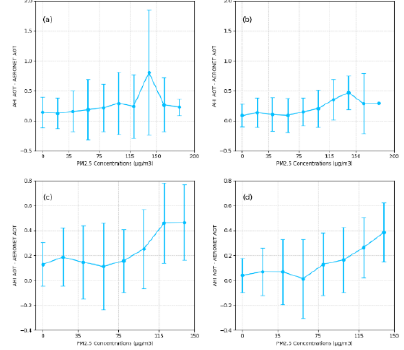
Figure 7. the bias between AHI AOTs and ground AOT under the different PM2.5 concentrations